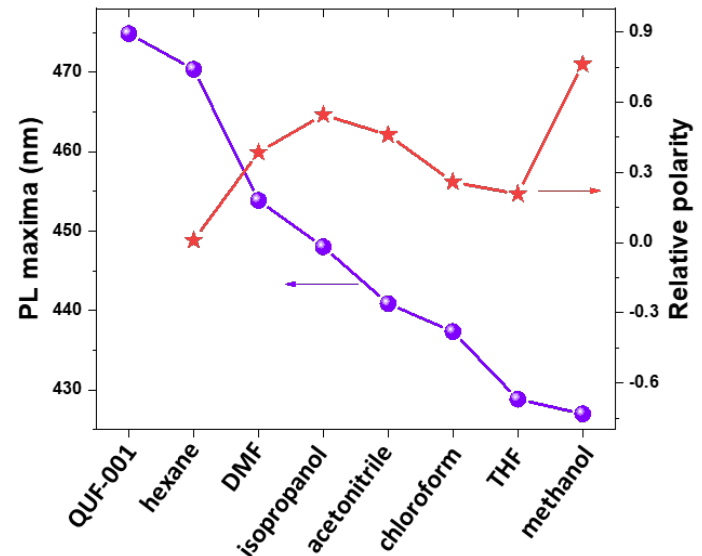
Figure 5. Trend in the PL maxima peak positions for activated QUF-001 and QUF-001 mixed with different solvents (violet cycles). All samples excited at 350 nm and compared with the solvent polarity (red stars).